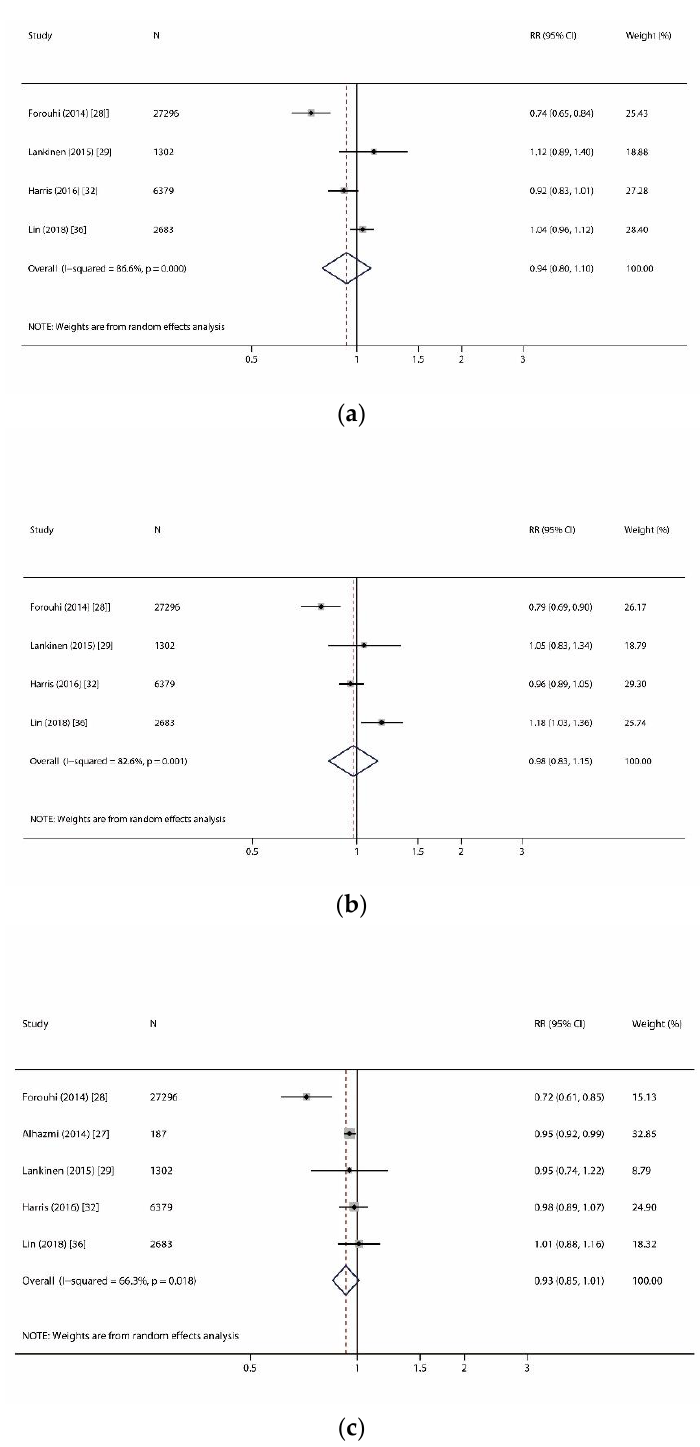
Figure 4. Forest plots of studies investigating the relationship of very-long-chain saturated fatty acids and incident type 2 diabetes. ( a ) Forest plot for arachidic acid (C20:0); ( b ) Forest plot for behenic acid (C22:0); ( c ) Forest plot for lignoceric acid (C24:0). RR: relative risk; CI: confidence interval.